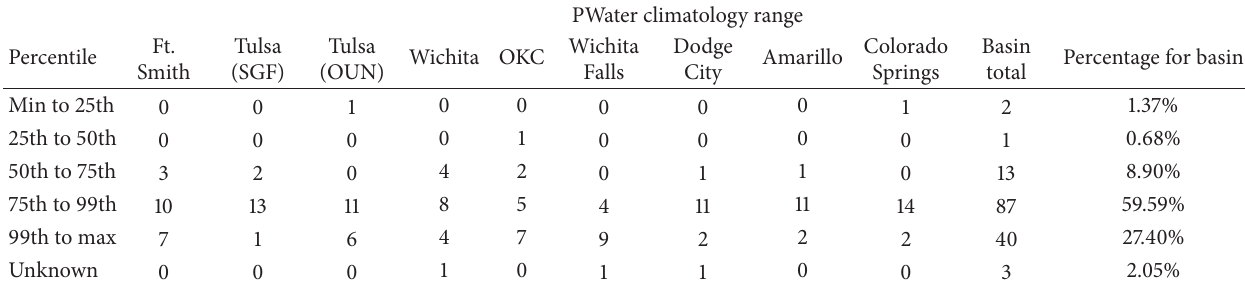
Table 9: Cases compared to the PWater climatology distribution by